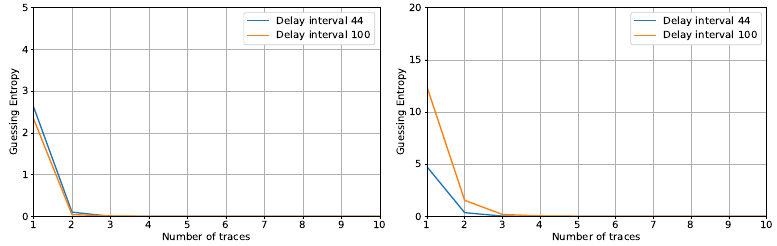
Figure 14: Guessing entropy of desynchronized datasets AT128-N (left) and AT128-F